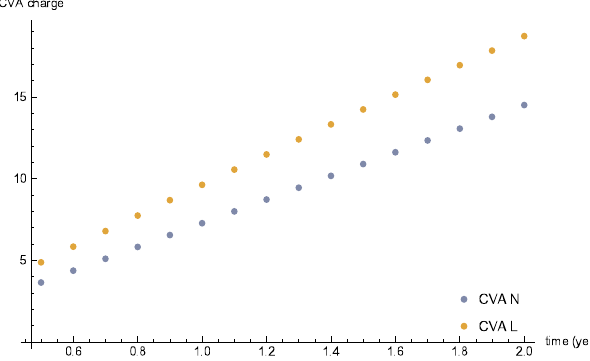
Figure 7. Comparison of CVA N and CVA L for Case